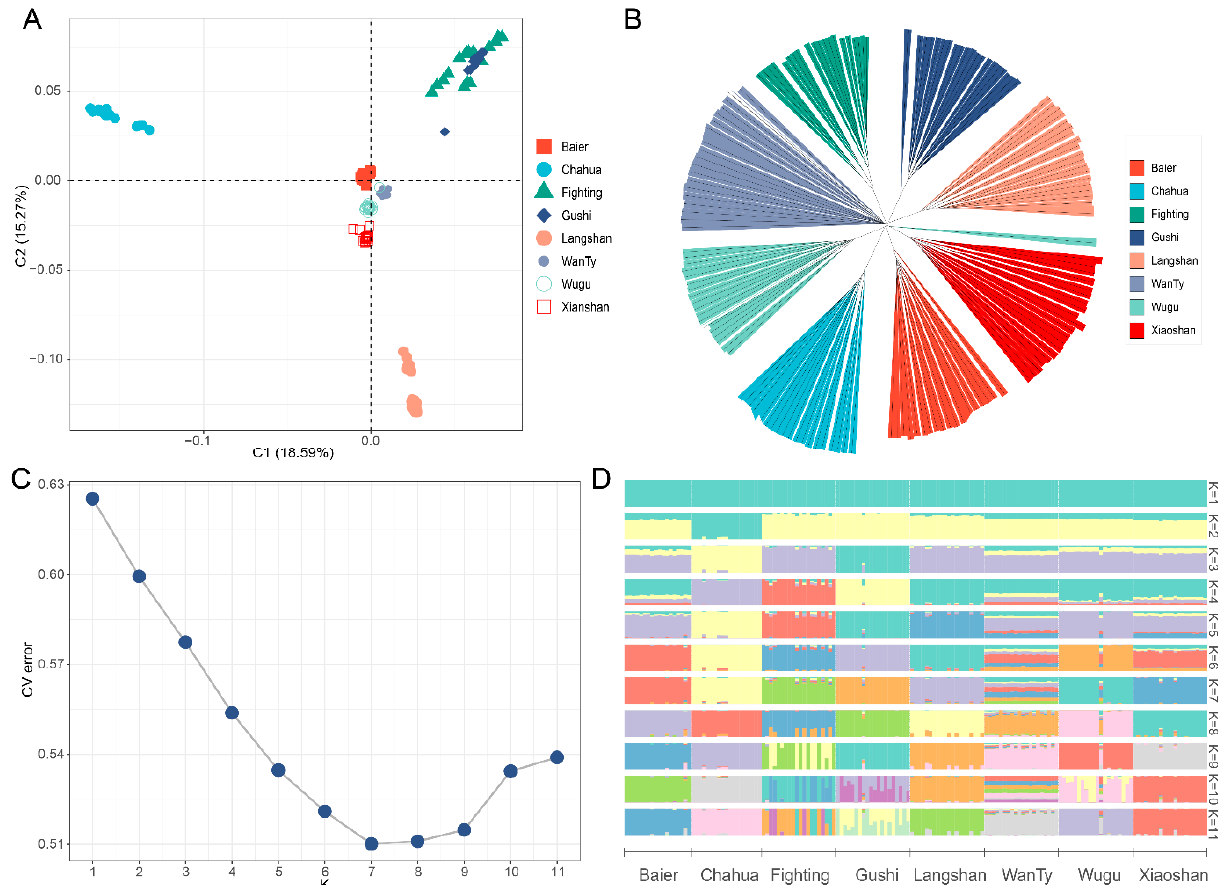
Figure 1. ( A ) MDS analysis and ( B ) phylogenetic tree of the eight indigenous breeds, ( C ) cross-vali- dation (CV) error rate and ( D ) population structure of the eight indigenous breeds.